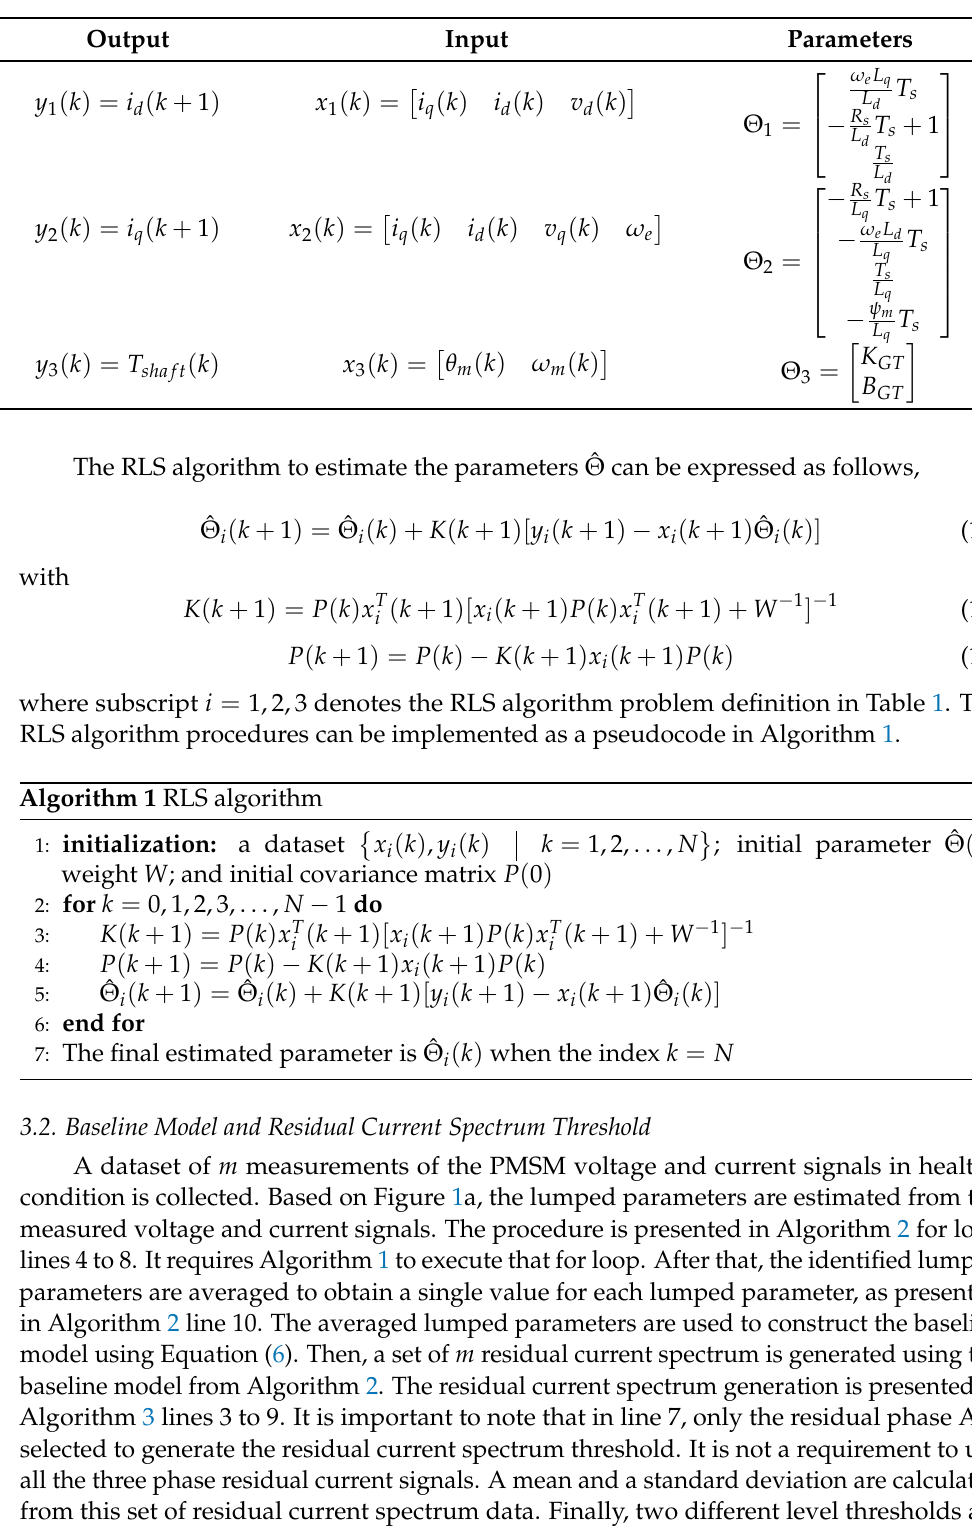
Table 1. The RLS algorithm problem definitions in this